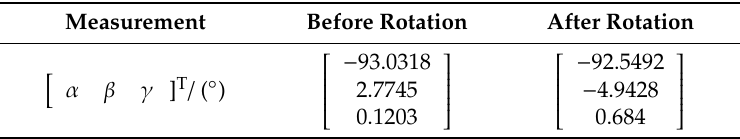
Table 3. Rotation incremental verification